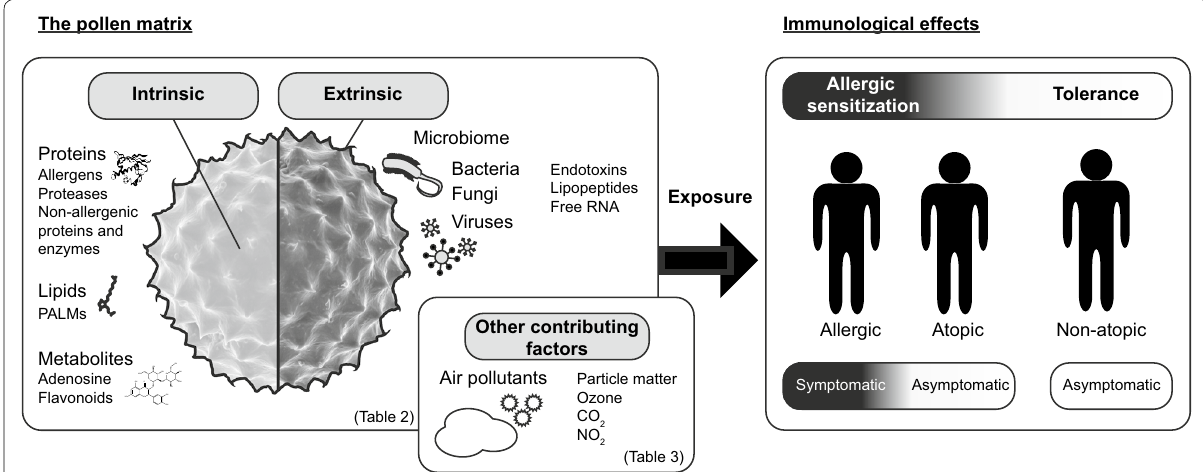
Fig. 2 The composition of the pollen matrix influencing the sensitizing potential of allergenic pollen sources. The intrinsic part consists of compounds inherent to the pollen and the extrinsic fraction, includes a prominent microbiome retaining diverse bacterial strains, viruses and fungi. Major immune stimulators can be proteins including allergens with intrinsic adjuvant activities, non‑allergenic proteases, but also lipids and metabolites such as PALMS, adenosine and flavonoids. Additionally, climate and exposure to air pollutants shape the composition of the pollen matrix. Details on the immunomodulatory activities of pollen matrix‑derived components as well as on the modulation of the matrix composition can be found in Tables 2 and 3. PALMs, pollen‑associated lipid mediators; CO 2 , carbon dioxide; NO 2 , nitrogen